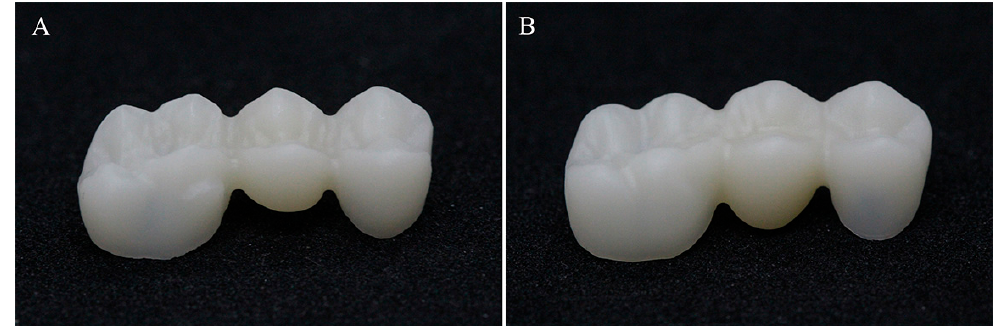
Figure 3. Three-unit fixed dental prosthesis fabricated using two digital workflows. ( A ) In-lab group. ( B ) Chairside group.